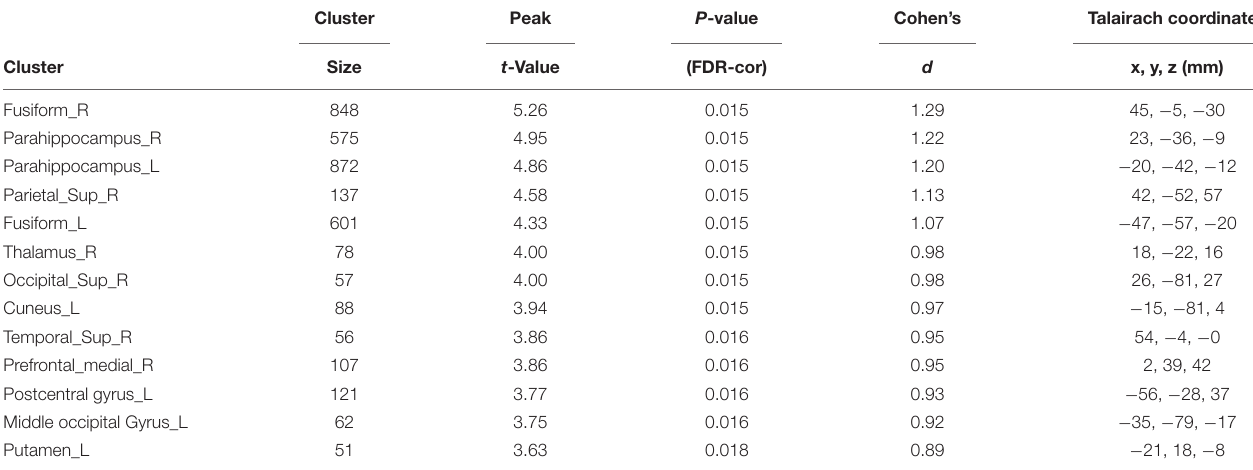
TABLE 2 | Voxel-based analysis of gray matter volume (GMV) in LBC relative to non-LBC study participants. Cluster Peak P -value Cohen’s Talairach coordinates